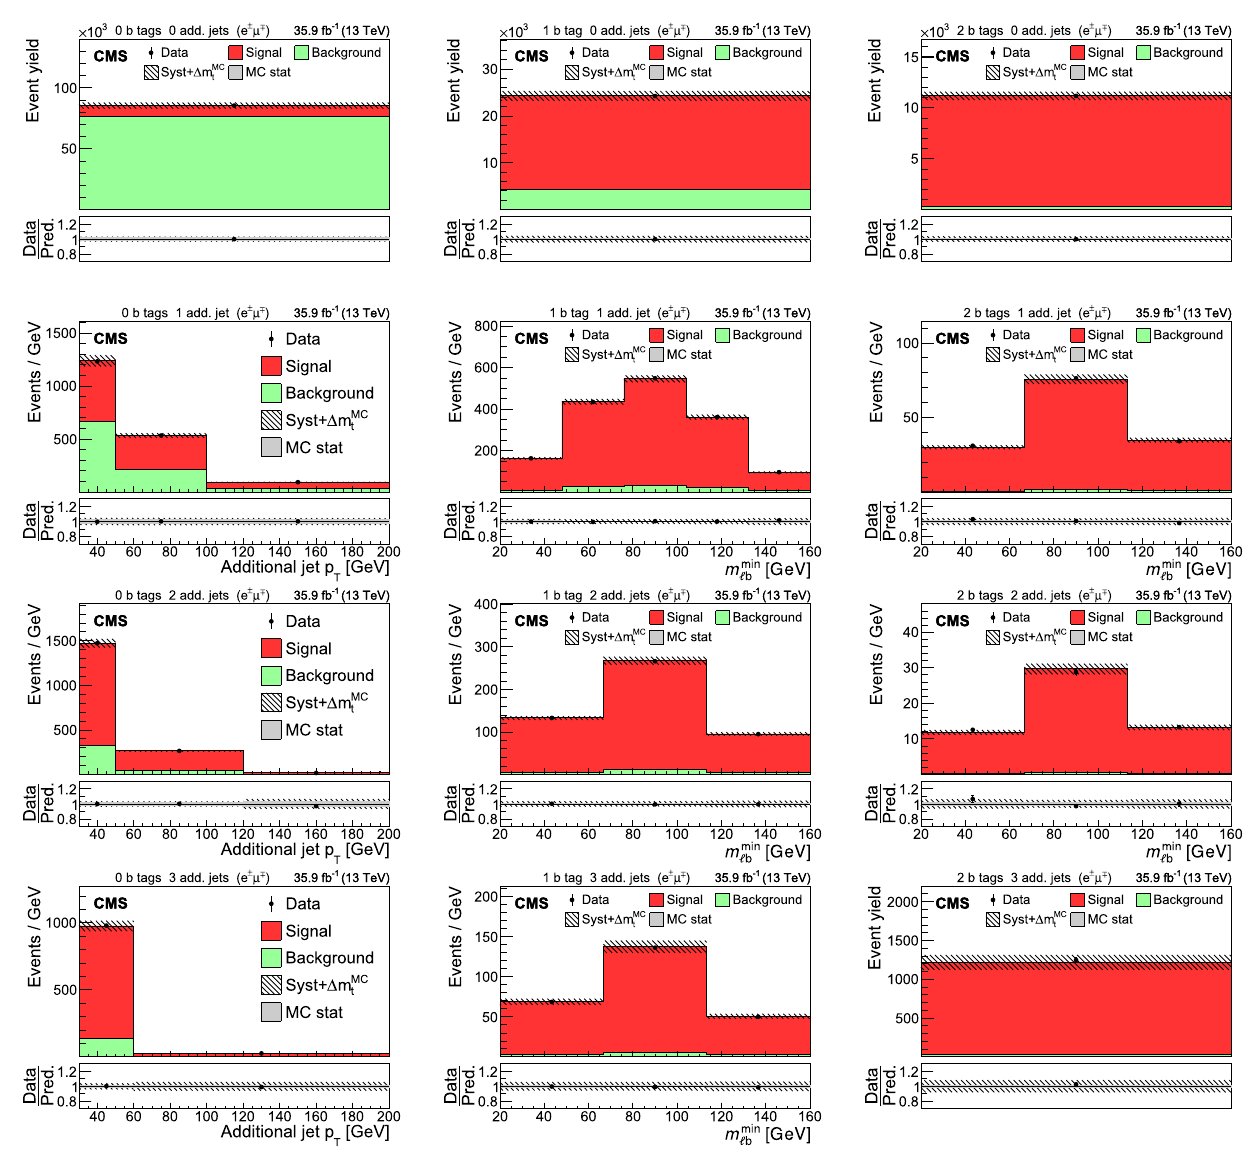
Fig. 9 Comparison of data (points) and post-fit distributions of the expected signal and backgrounds from simulation (shaded histograms) used in the simultaneous fit of σ tt and m MC t in the e ± μ ∓ channel. In the left column events with zero or three or more b-tagged jets are shown. The middle (right) column shows events with exactly one (two) b-tagged jets. Events with zero, one, two, or three or more additional